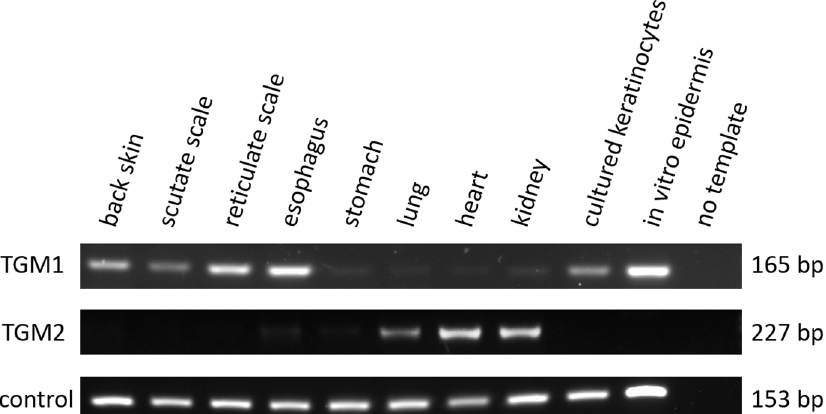
Figure 2. Expression analysis of TGM1 and TGM2 in chicken tissues and cells. RNA from the indicated tissues and cultured cells was subjected to RT-PCR with primers specific for TGM1 , TGM2 , and the house-keeping gene EEF1A1 (control). PCR products were analyzed by agarose gel electrophoresis, revealing bands that correspond to the predicted size of the PCR products.